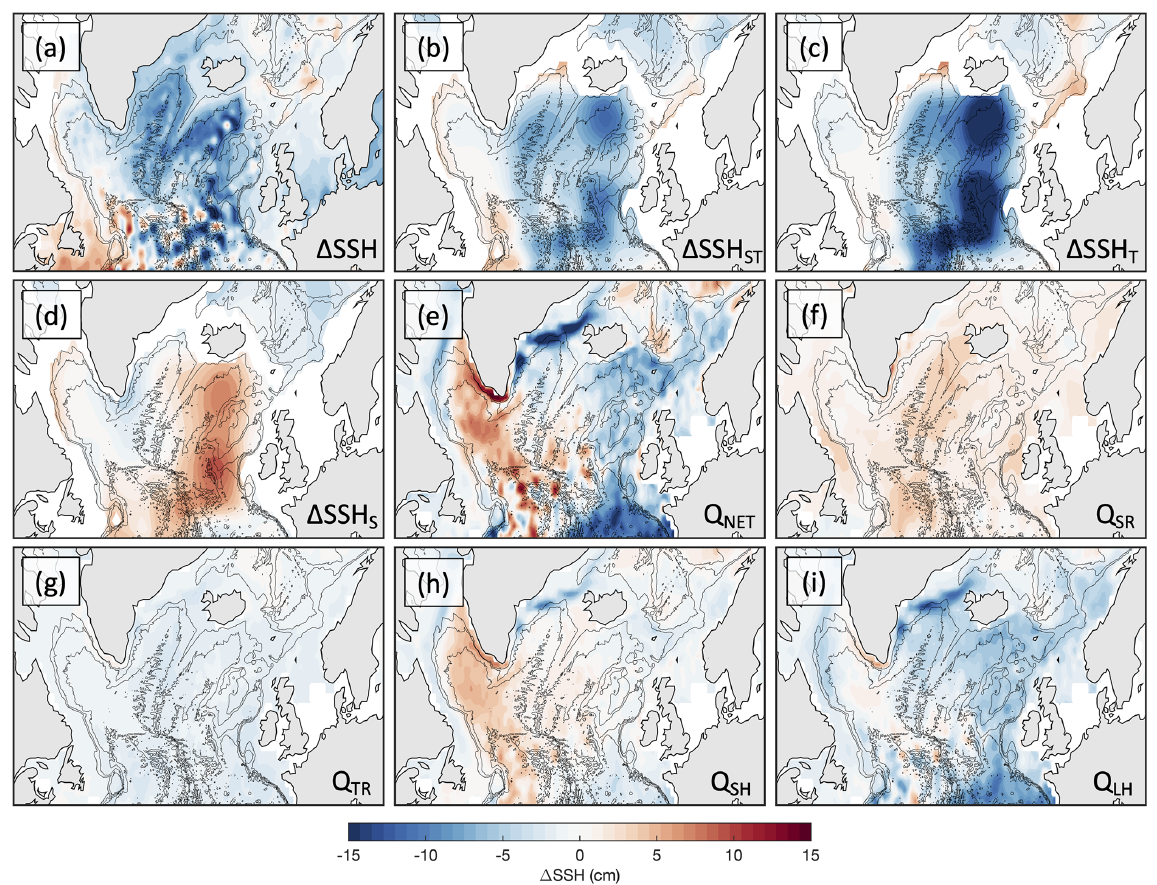
Figure 13. Same as Fig. 12 but for the 2004–2014